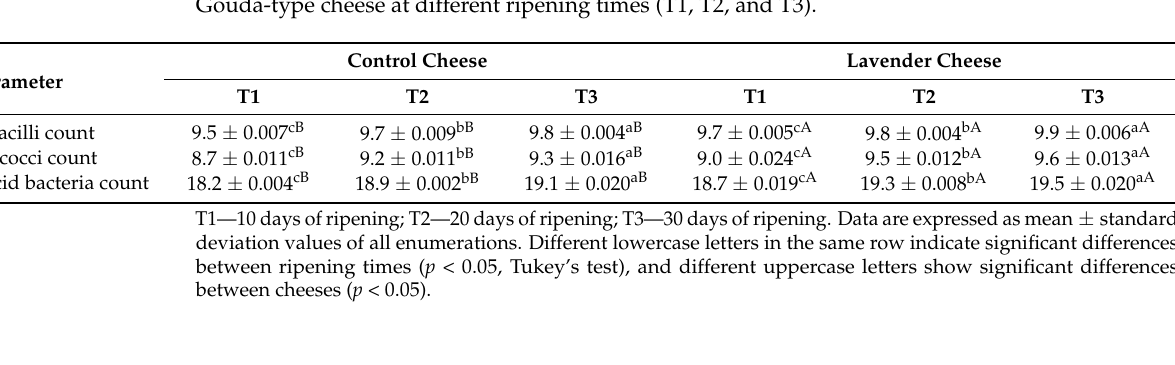
Table 3. Counts of lactobacilli, streptococci, and total lactic acid bacteria in control and lavender Gouda-type cheese at different ripening times (T1, T2, and